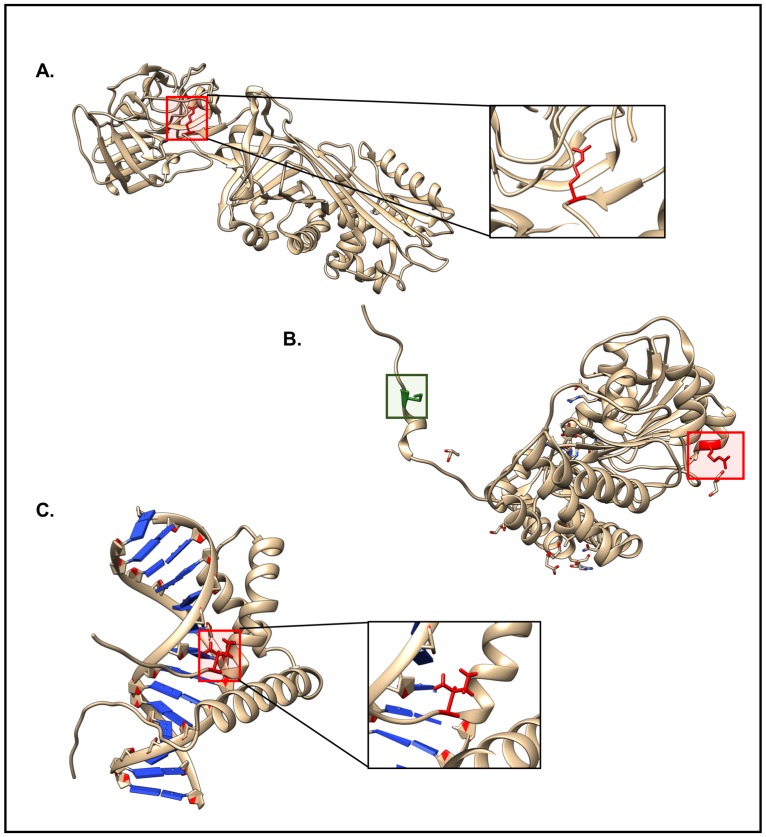
Examples of special cases.A) PDB: 1OPH. The highlighted residue in red represents the mutation (M358R) site. Due to this mutation, alpha1-antitrypsin loses its function as an elastase inhibitor, retains its function as a trypsin inhibitor, and gains a function as a thrombin inhibitor. B) PDB: 1J04. The two highlighted regions represent the two polymorphisms that act synergistically. The highlighted region in green represents P11L polymorphism in AGT whereas the highlighted region in red represents the disease-specific G170R mutation. C) PDB: 1J47. The highlighted red residue represents the M64I in the full-length hSRY sequence, which corresponds to M9I in the given construct and affects the extent of DNA bending.